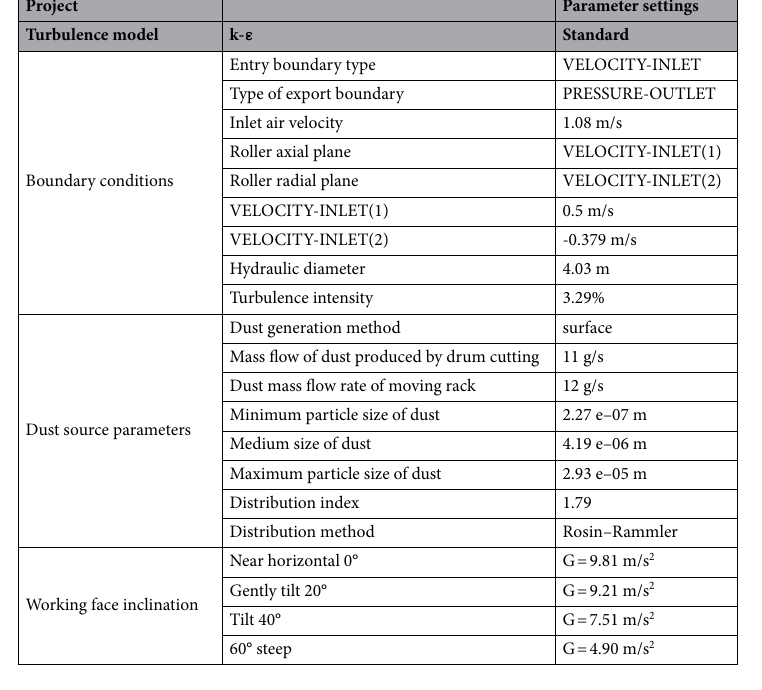
Table 2. Basic parameter